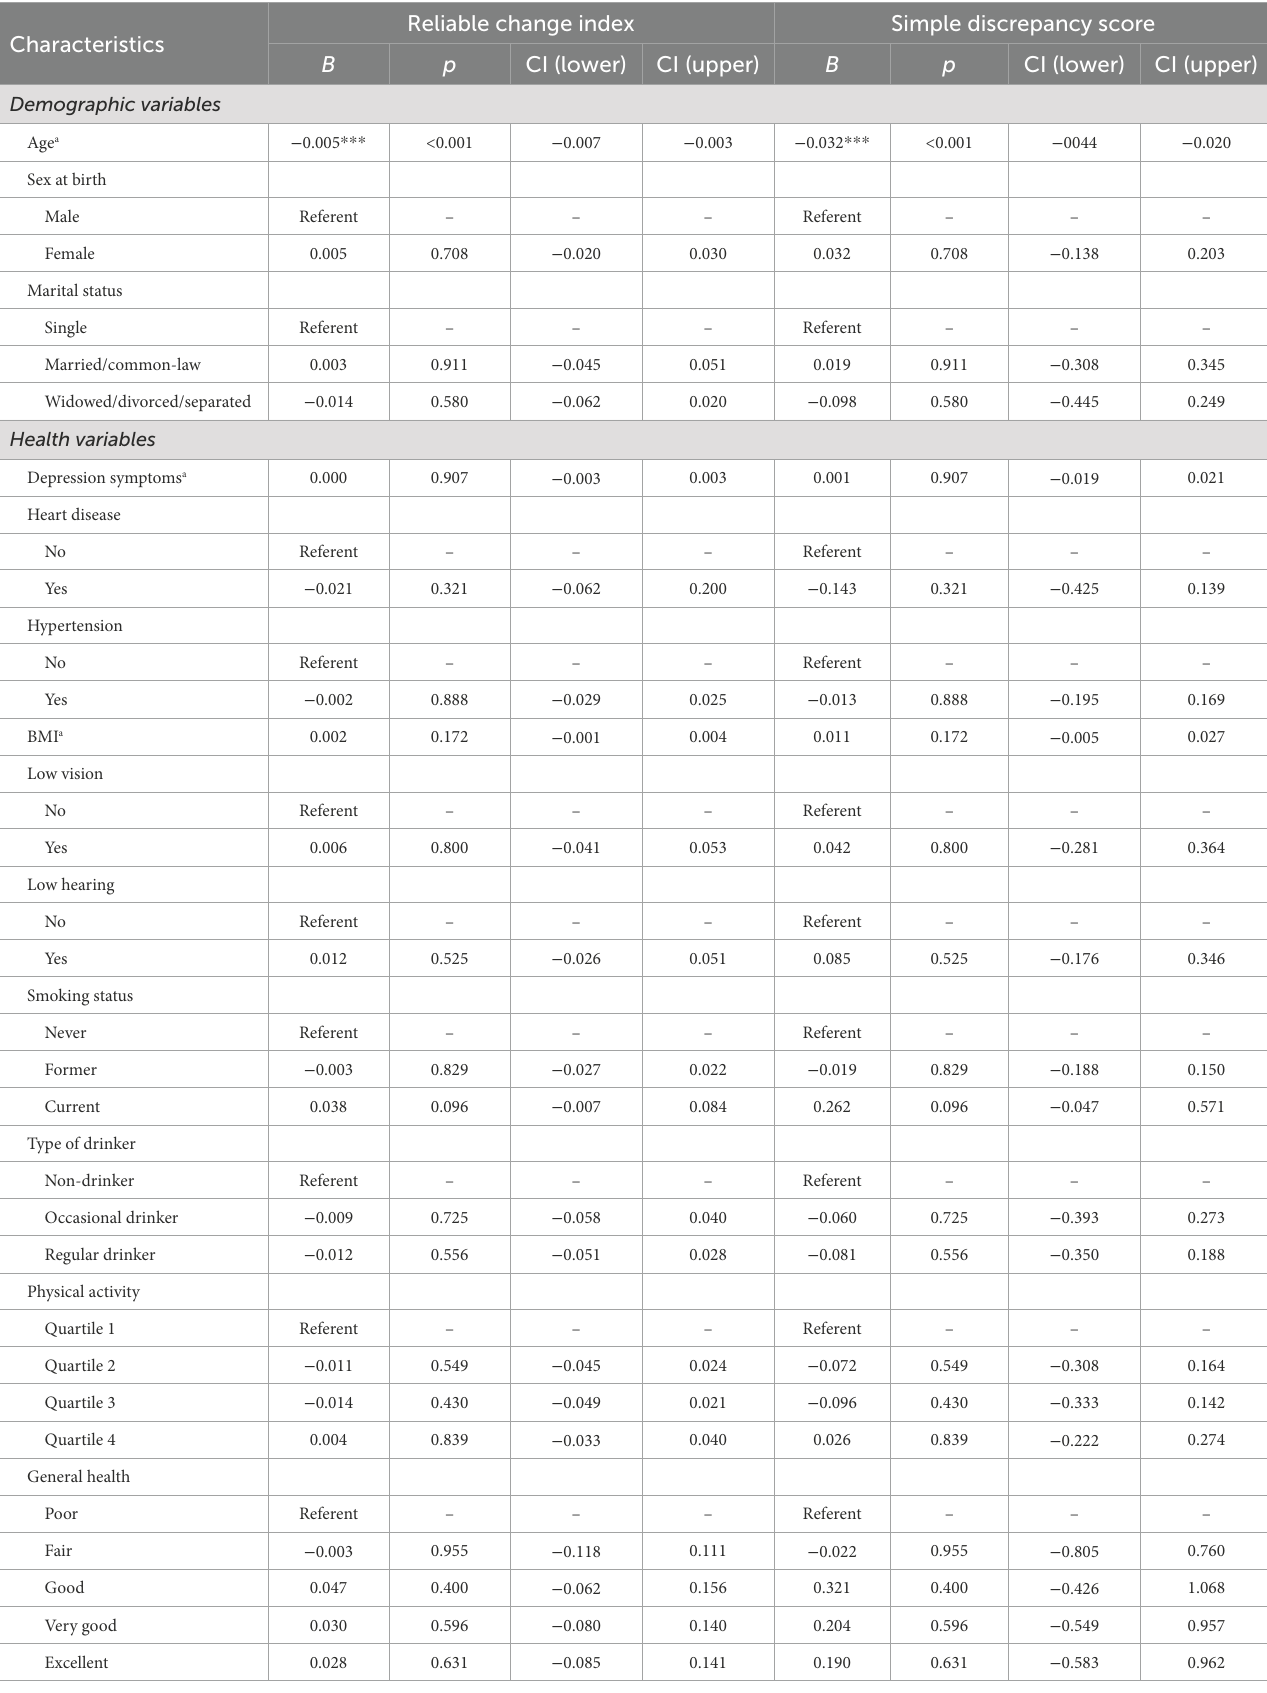
TABLE 2 Results of a multiple linear regression with reliable change index and simple discrepancy score for executive function as the outcome ( n = 29,334).